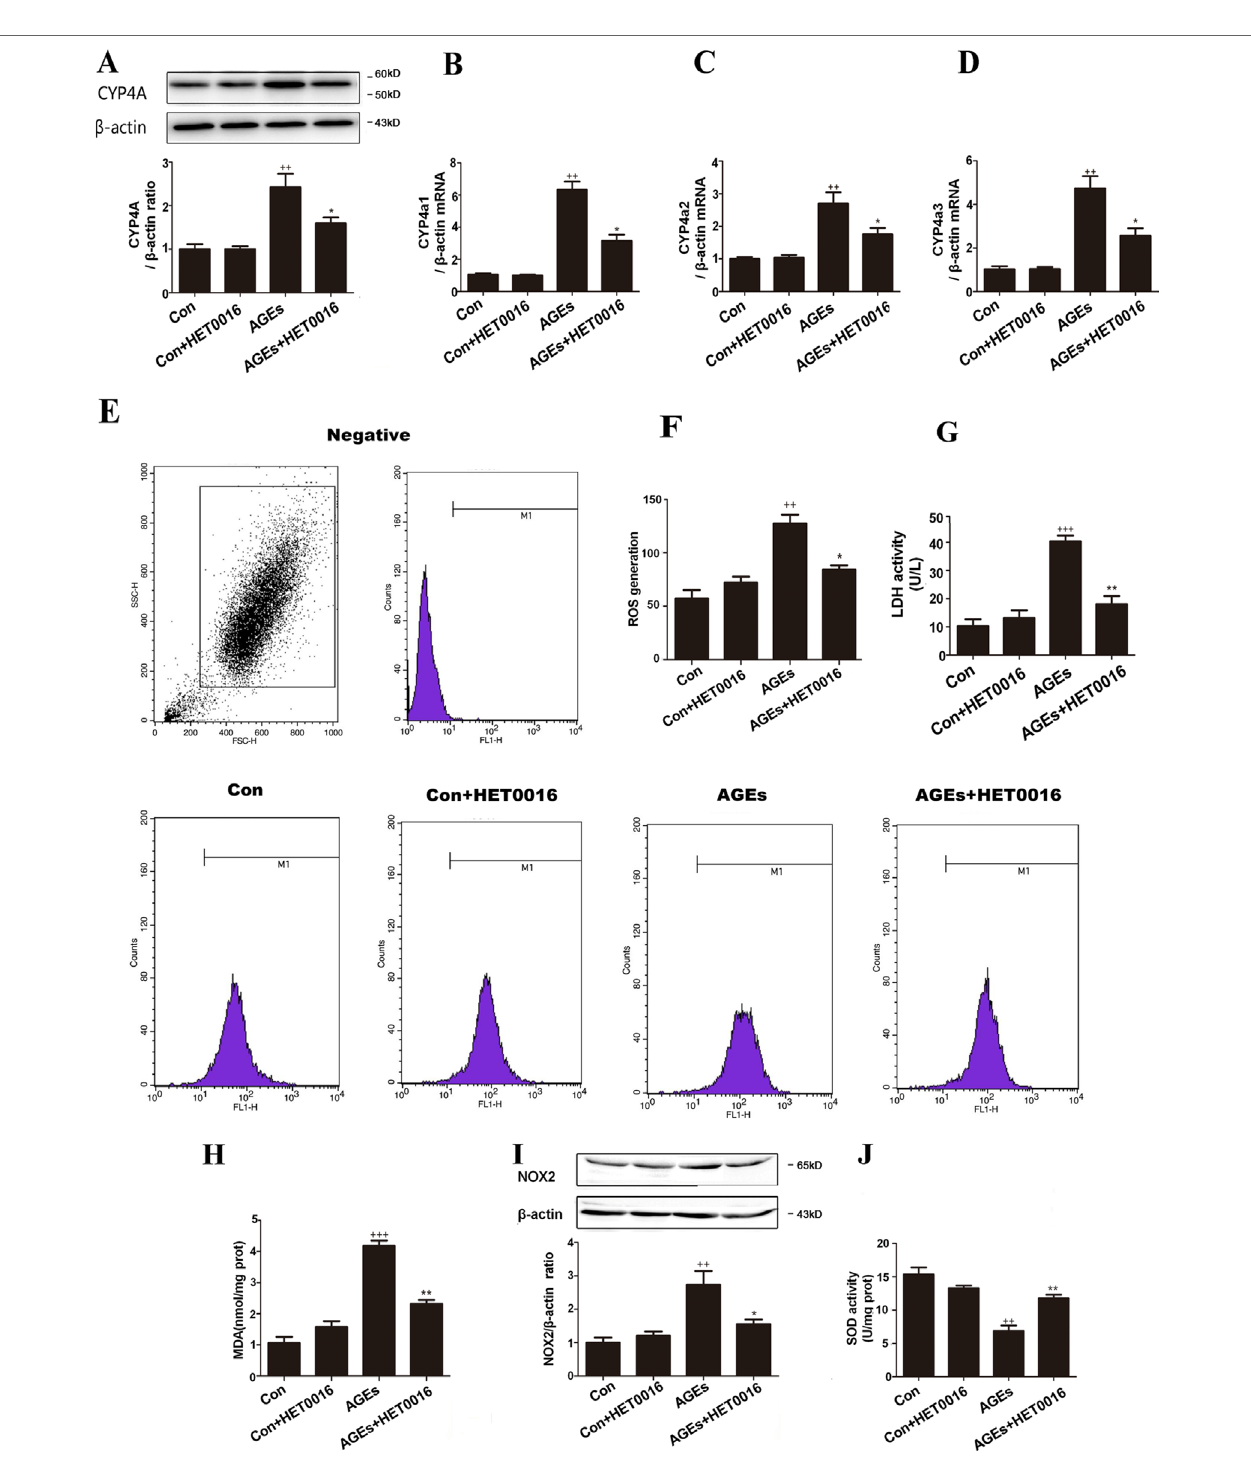
FIGURE 3 | Inhibition of CYP4A with HET0016 protects H9c2 cells from AGEs-induced oxidative stress. (A) Protein expression of CYP4A, n = 3. (B–D) mRNA expressions of CYP4a1, CYP4a2, CYP4a3, n = 3. (E) Level of intracellular ROS generation. (F) A summary of flow cytometry analyses of cells stained with 2,7-dichlorodihydrofluoresceindiacetate (DCFH-DA), n = 3. (G) LDH activity in the medium, n = 6. (H) Content of MDA, n = 6. (I) Protein expression of NOX2, n = 3. (J) Activity of SOD, n = 6. H9c2 cells at a density of 1 × 10 5 cells per well were seeded on six-well plates and treated at the time of 90% confluence. HET0016 or vehicle in fetal bovine serum (PBS)-free media (2 μ M) was added 1 h before exposure to 10 μ M AGEs or bovine serum albumin (BSA) for 24 h. Con, control. Compared with the Con group, ++p < 0.01, +++p < 0.001; compared with the AGEs group, *p < 0.05, **p < 0.01 (one-way ANOVA with Tukey post hoc